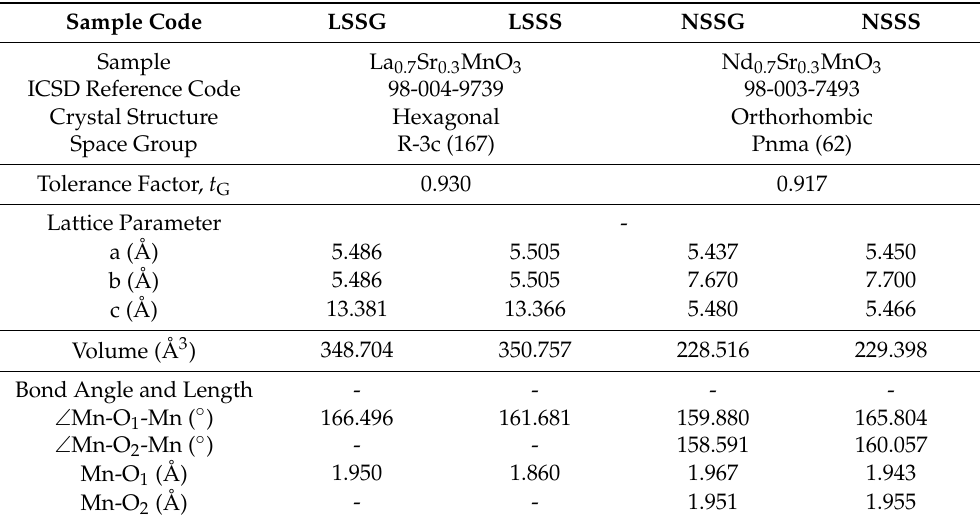
Table 1. Tolerance factor and structural parameters obtained from the Rietveld refinement of the XRD patterns for LSSG, LSSS, NSSG, and NSSS.